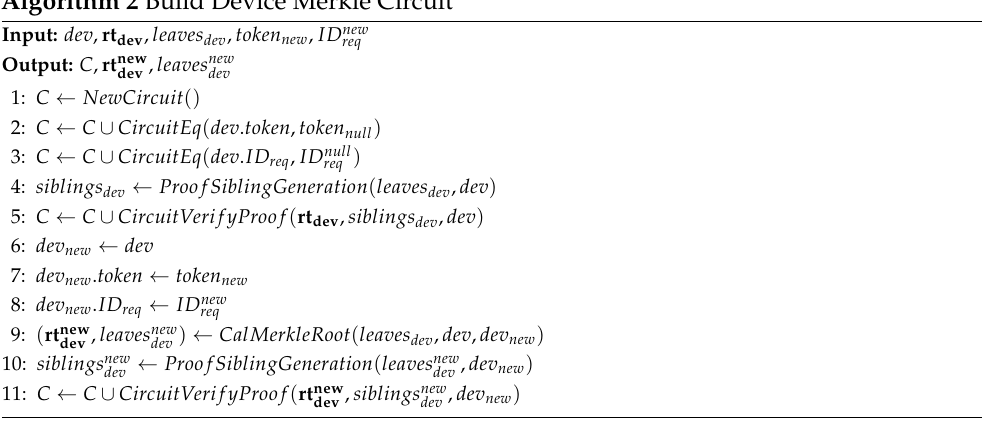
Algorithm 2 Build Device Merkle Circuit